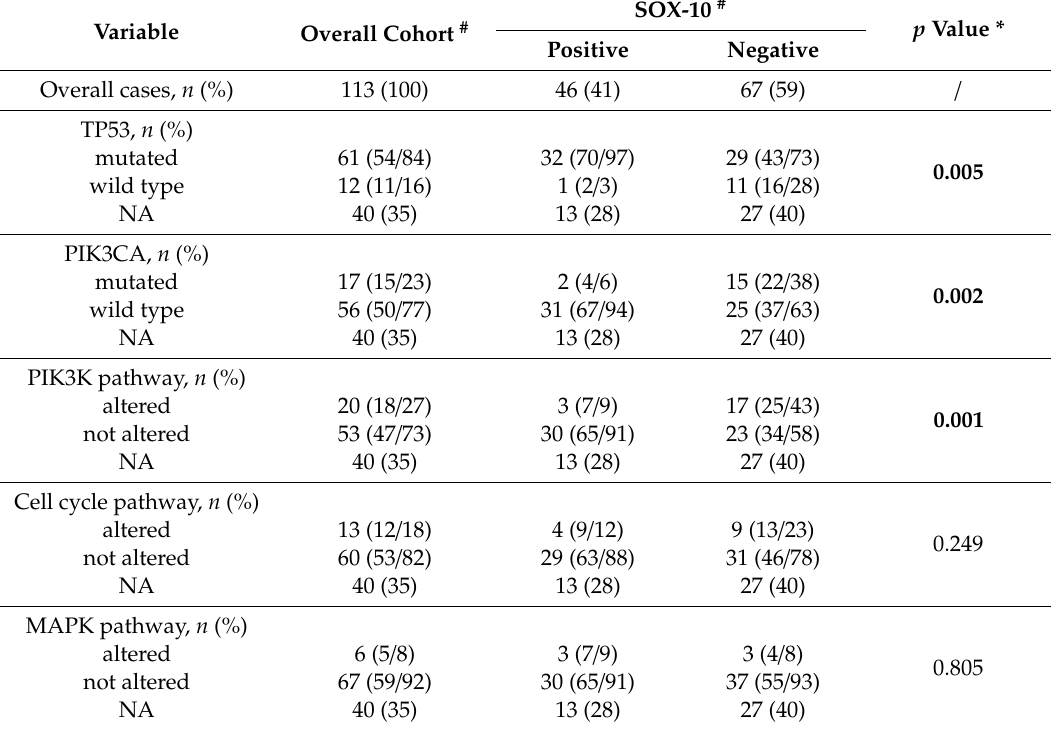
Table 3. Molecular genetic characteristics with regard to SOX-10 expression.